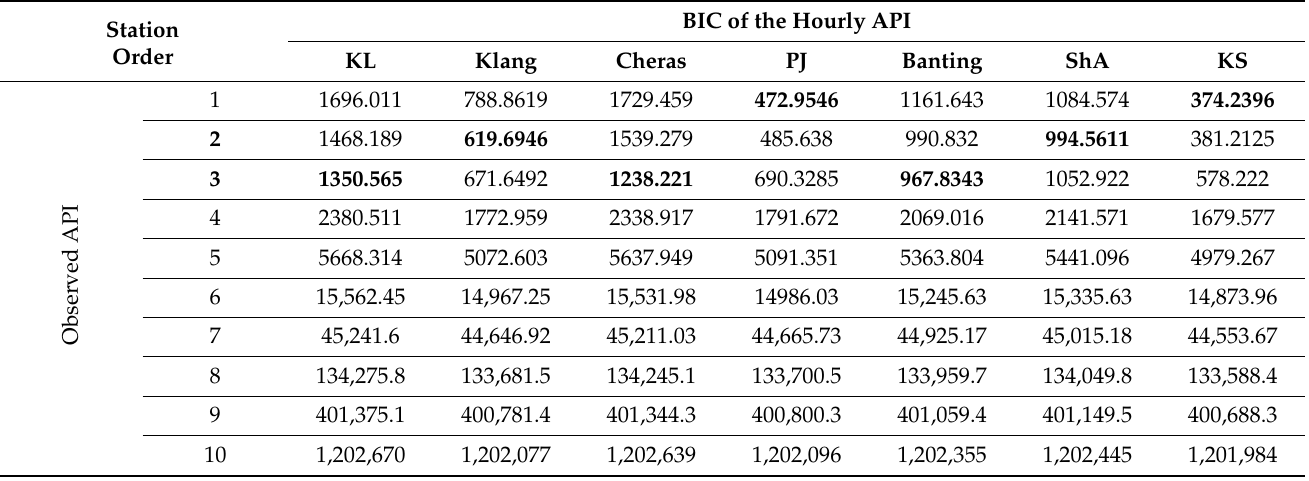
Table 3. The values of AIC and BIC for each MC model using the hourly